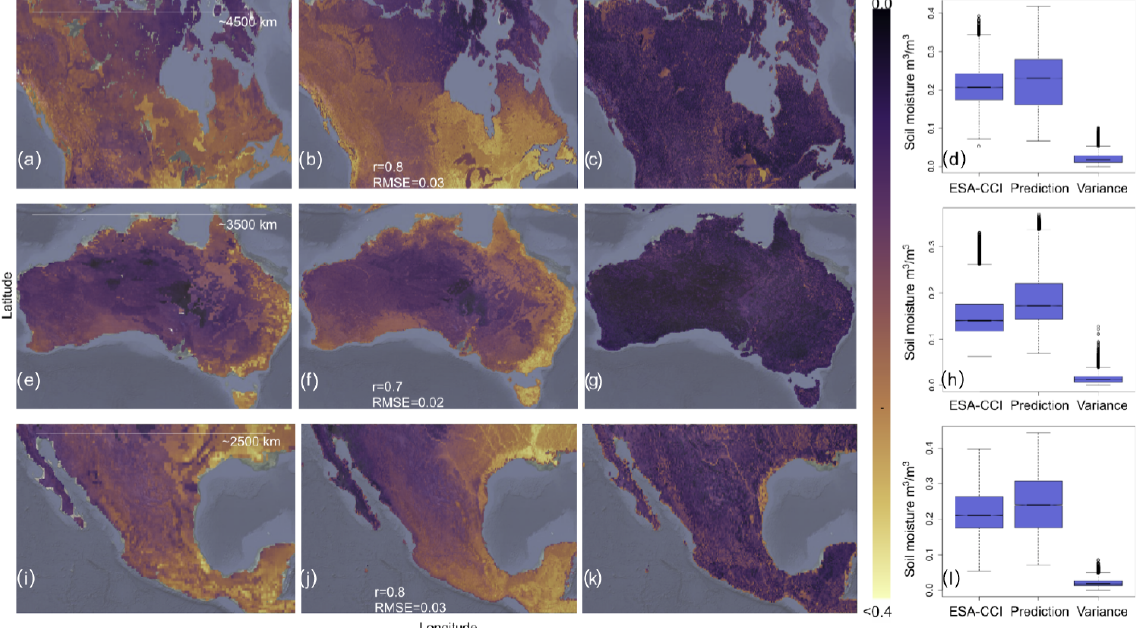
Figure 5. Examples of downscaled annual mean soil moisture across specific countries. Prediction of soil moisture, prediction variance, and training data from the ESA-CCI across Canada (CAN; a–c ), and their respective boxplots (showing their statistical distribution) for the year 2018 (d) . Prediction of soil moisture, prediction variance, and training data from the ESA-CCI across Australia (AUS; e–g ), and their respective boxplots for the year 2018 (h) . Prediction of soil moisture, prediction variance, and training data from the ESA-CCI across Mexico (MEX; i–k ), and their respective boxplots for the year 2018 (l)